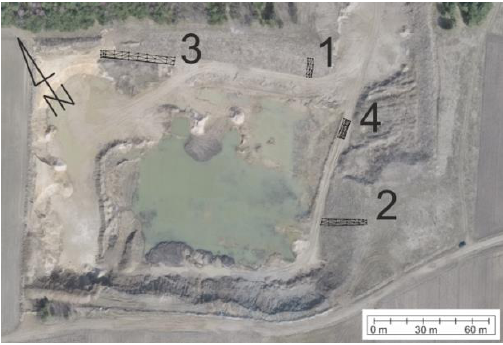
Figure 9. Distribution of measured cross- sections for further accuracy analyses.